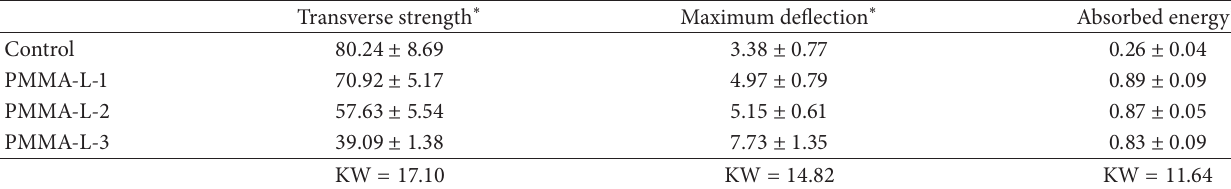
Table 2: Value of transverse and impact strength of composite